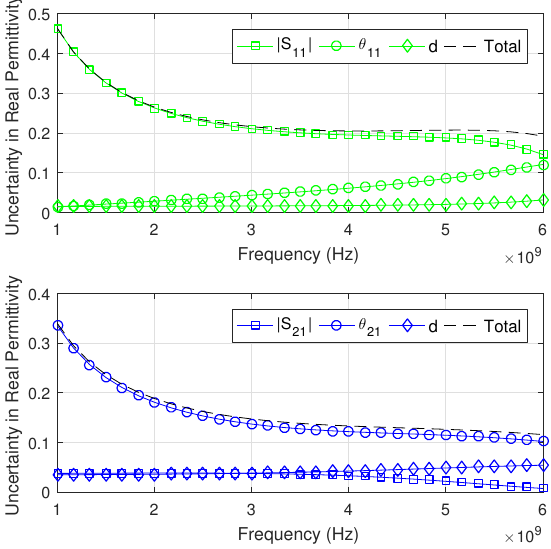
Figure 10. The uncertainty in the real part of permittivity ( ∆ ε (cid:48) r ) due to the uncertainties in the magnitude and phase of the S-Parameters and in the thickness d . The reflection configuration is on the top, whilst the transmission is on the